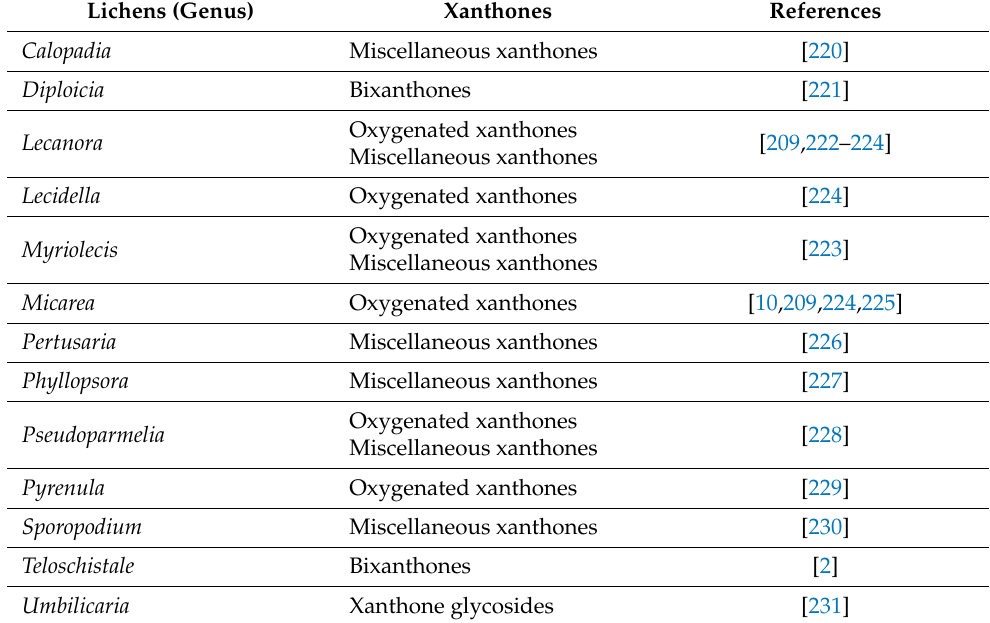
Table 3. Xanthones in Lichens.